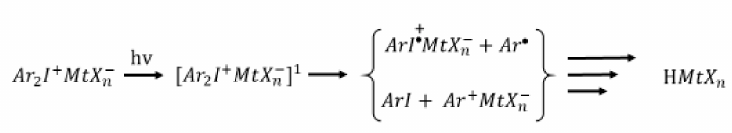
Figure 3. Simplified photodecomposition of a general diaryliodonium